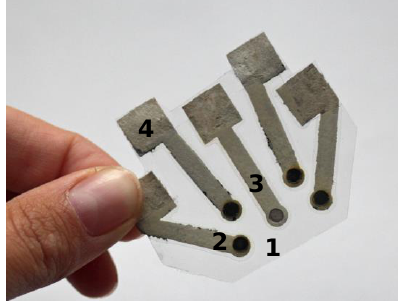
Figure 3. Paper-based electronic tongue system applied for discrimination of beer and wine samples 1. lamination sheet serving as support, 2. ion-selective electrode, 3. reference electrode, 4. electrical connections (reprinted with permission from [17] © Elsevier).